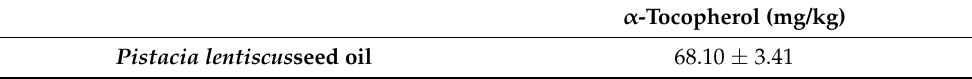
Table 5. α -Tocopherol content (mg/kg) of Pistacia lentiscus seed oil (PLSO). α -Tocopherol (mg/kg) Pistacia lentiscus seed oil 68.10 ±